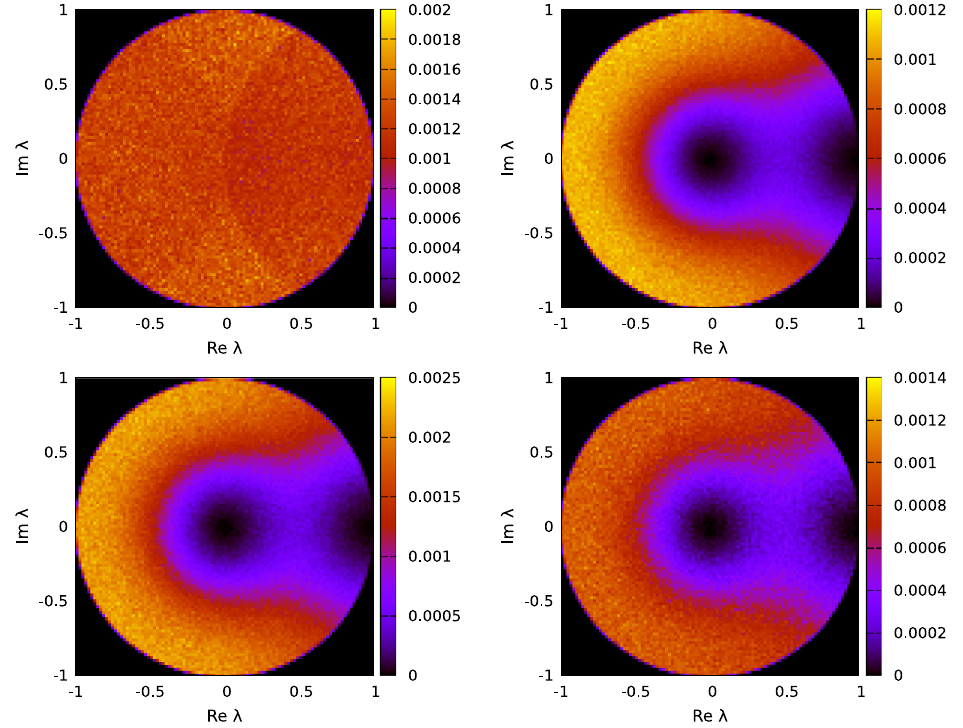
.FIG. 5. Distribution of complex spacing ratios, Eq. (17), for N ¼ 20 and q ¼ 2 (top-left panel), 3 (top-right panel), 4 (bottom-left panel), and 6 (bottom-right panel). Suppression of the complex spacing ratio density around the origin and along the real positive semiaxis is observed for q > 2 . This is also the random matrix theory prediction [70], which should indicate quantum chaotic